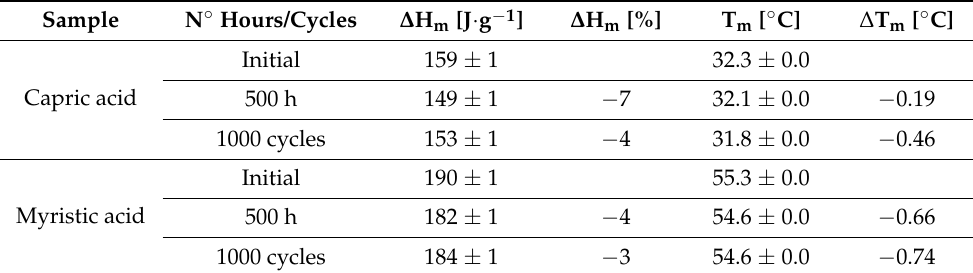
Table 1. DSC results: melting temperature and melting thermal and cycling stability results. ∆ H m [%] are melting enthalpy variation expressed in % regarding the initial value and ∆ T m [ ◦ C] are tempera- ture increment in the different